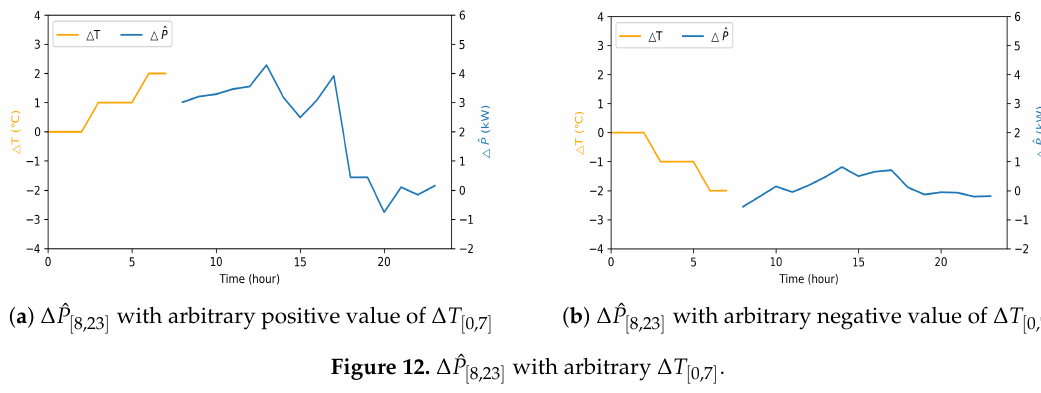
Figure 11. Training data: temperature and load forecast deviations for 86 days in 2010.